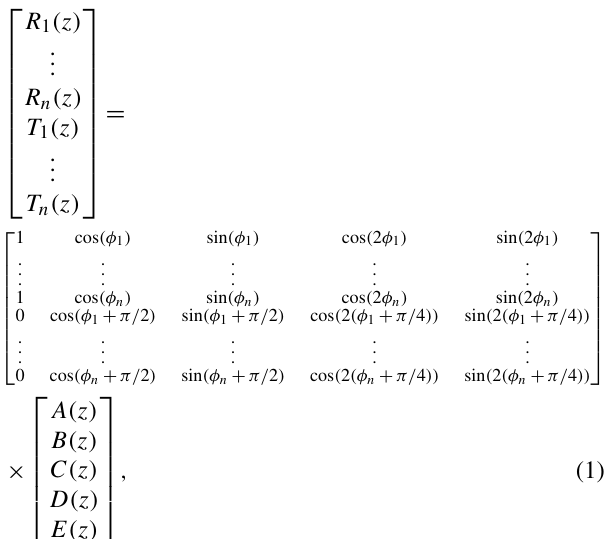
Figure 5. Example of results obtained at station PFBR using the harmonic stripping method of Bianchi et al. (2010). (a) The har- monic functions obtained by solving Eq. (1) are represented from top to bottom: A(z) , first harmonic degree ( k = 0); B(z) , cos (φ) term of the second degree harmonic ( k = 1); C(z) , sin (φ) , term of the second degree harmonic ( k = 1); D(z) , cos ( 2 φ) term of the third ( k = 2) harmonics; and E(z) , sin ( 2 φ) term of the third ( k = 2) har- monics. (b) The energy is represented for harmonic degrees k = 1 and k =